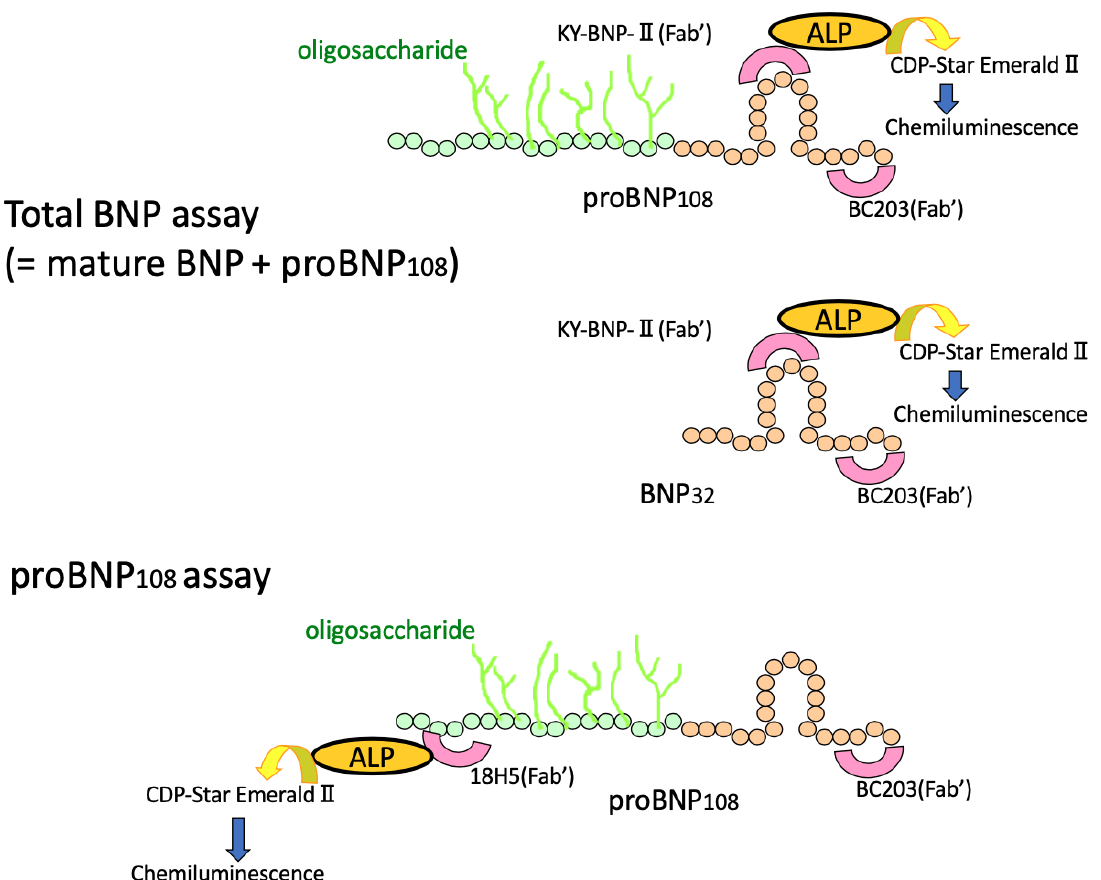
Figure 5. Schematic diagram of the total BNP and proBNP assay systems. BC203, a monoclonal antibody that specifically recognizes the C-terminus of BNP, is used as a capture antibody for both total BNP and proBNP. KY-BNP-II (Fab’), a monoclonal antibody that specifically recognizes the ring structure of BNP, is used as a detection antibody for total BNP assay. 18H5 (Fab’), a monoclonal antibody that specifically recognizes the N-terminus of proBNP, is used as a detection antibody for proBNP assay. ALP: Alkaline phosphatase; CDP-Star EmeraldII (Chemiluminescent Sub- strate): Disodium2-chloro-5-(4-methoxy-spiro{1,2-dioxetane-3,2 (cid:48) -(5 (cid:48) -chloro)-tricyclo[3,3,1,13,7]decan}- 4-yl)-1-phenyl